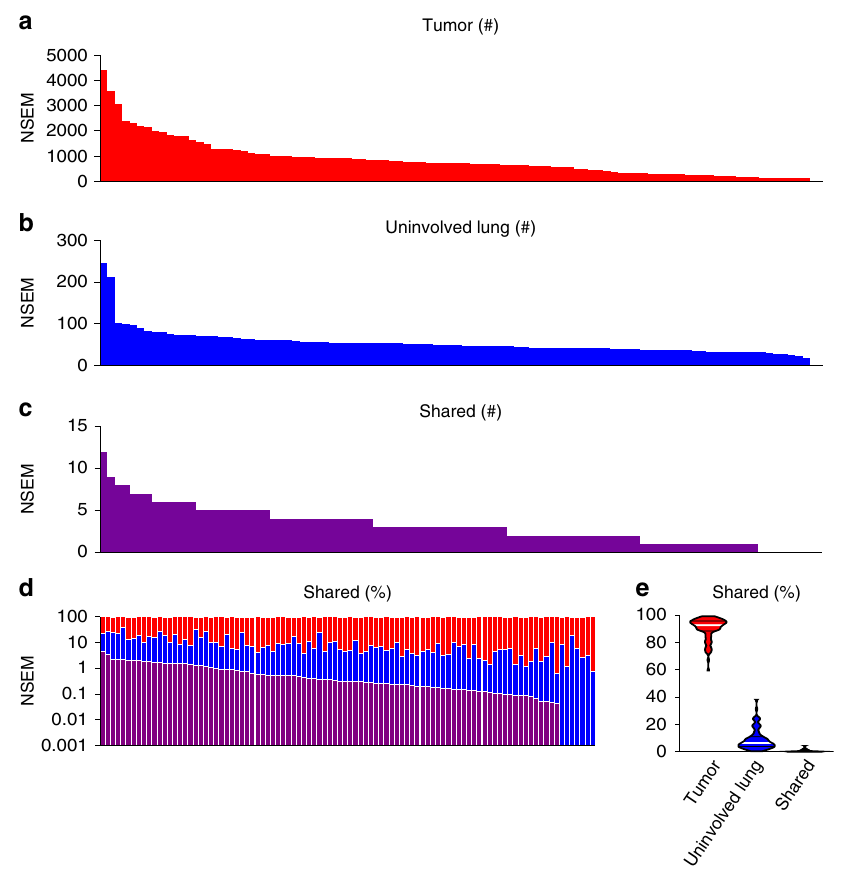
Fig. 7 Some mutations are shared between the tumor and adjacent uninvolved lung. a Tumor mutational burden in patients with NSCLC ( n = 96). b Mutational burden in the tumor-adjacent uninvolved lung ( n = 96). c Number of mutations shared between the tumor and tumor-adjacent uninvolved lung ( n = 96). d – e Proportion of mutations found exclusively in the tumor (red), in the tumor-adjacent uninvolved lung (blue), or shared (purple) ( n =